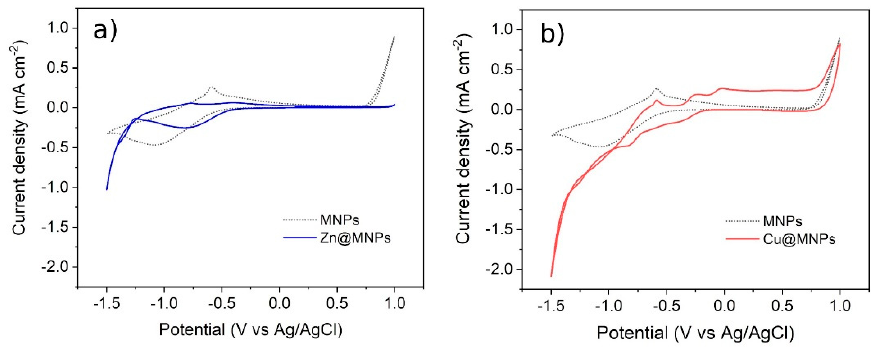
Figure 18. Cyclic voltammetry on MA used in the treatment of wastewater samples, ( a ) Zn 2+ -absorbed MA. ( b ) Cu 2+ -absorbed MA. (Dotted curve: functionalized MA with no ions absorbed).